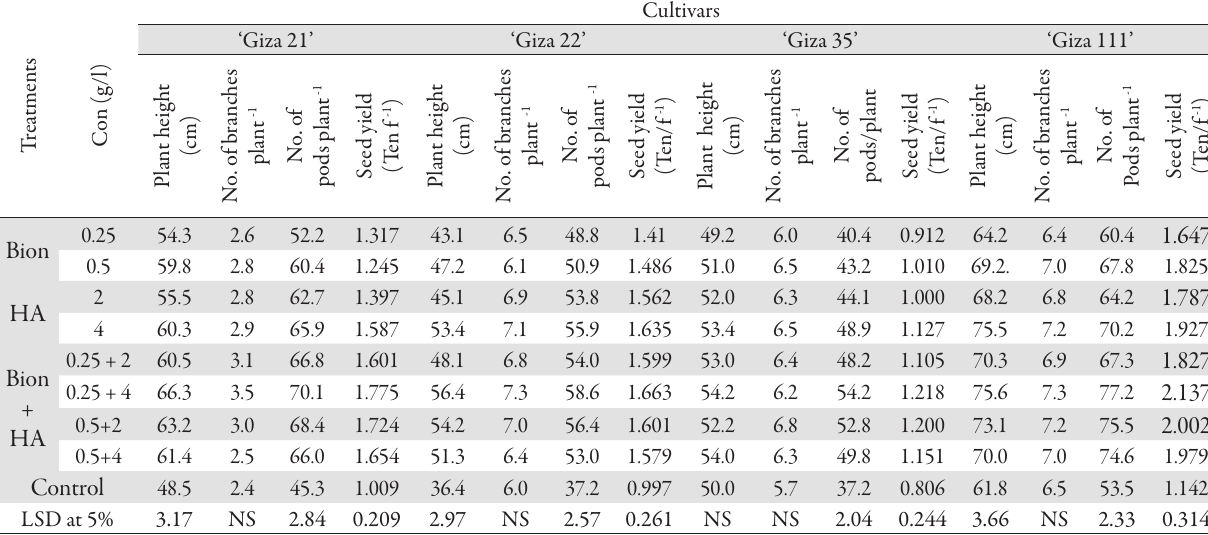
Tab. 6. Effect of BTH and HA on the growth parameters of the four soybean cultivars under field conditions Minia governorate at summer season